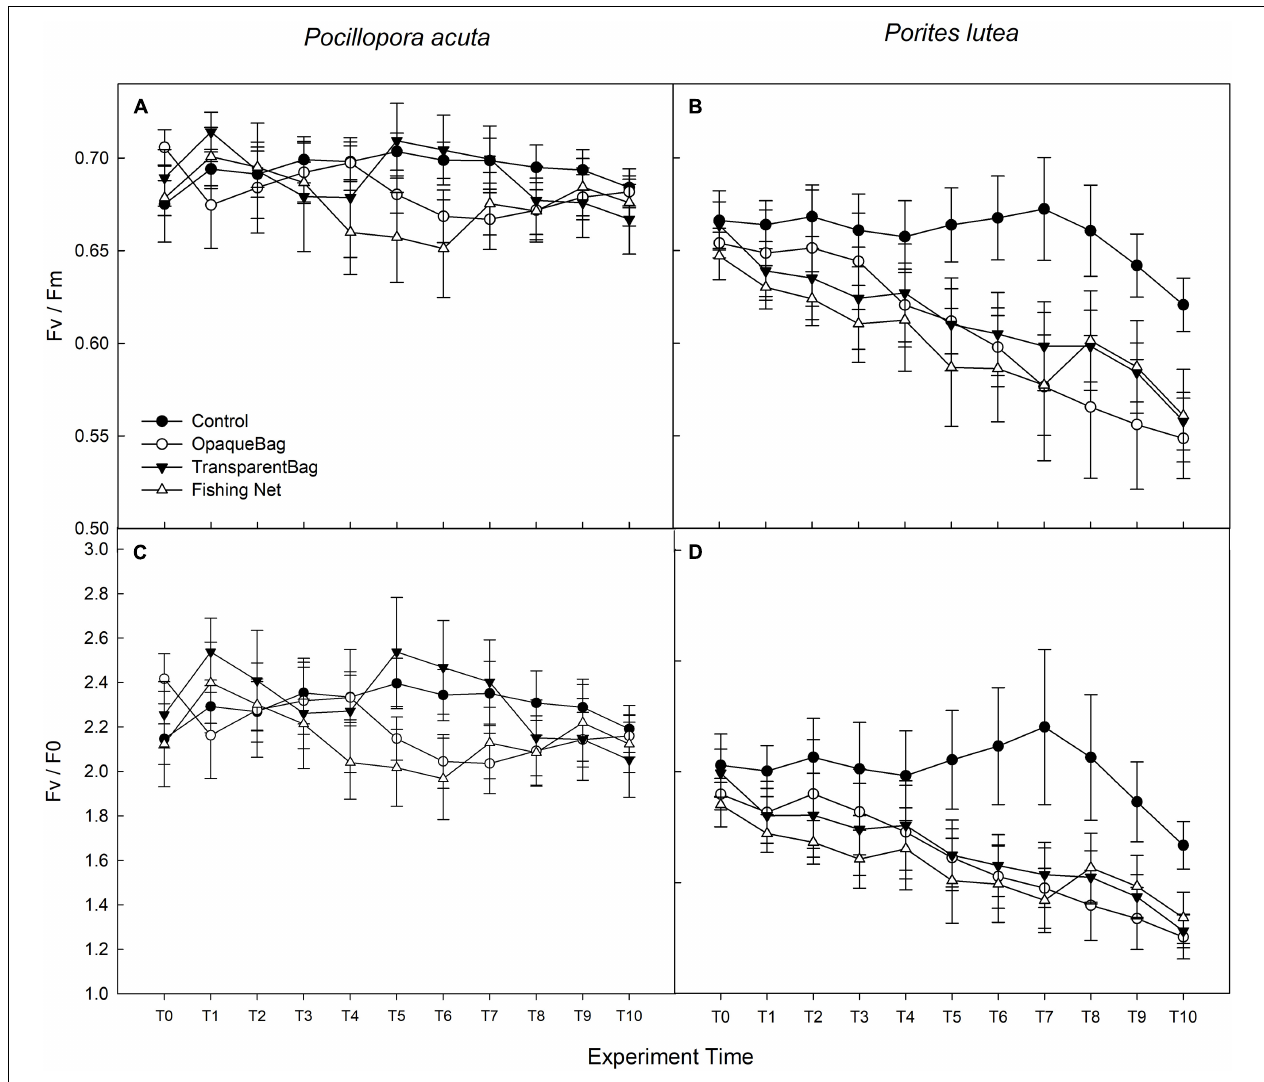
FIGURE 3 | Maximum quantum yield of PSII ( F v / F m ; A,B ) and F v / F 0 (C,D) in P. acuta (left column), and P. lutea (right column) from T0 to T10 (Graph treated with moving average, T1 in week 1, T4 in week 2, T7 in week 3, and T10 in week 4). Data are presented as Mean ± SE ( n =